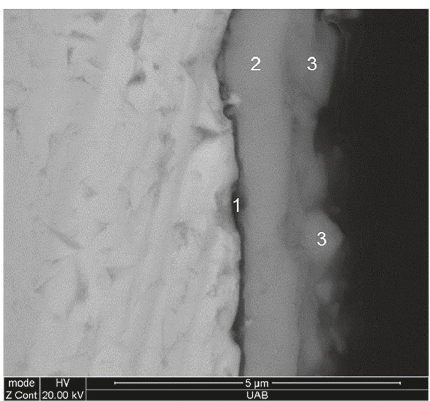
Figure 19: SEM image of cross section of the B-127 (Al